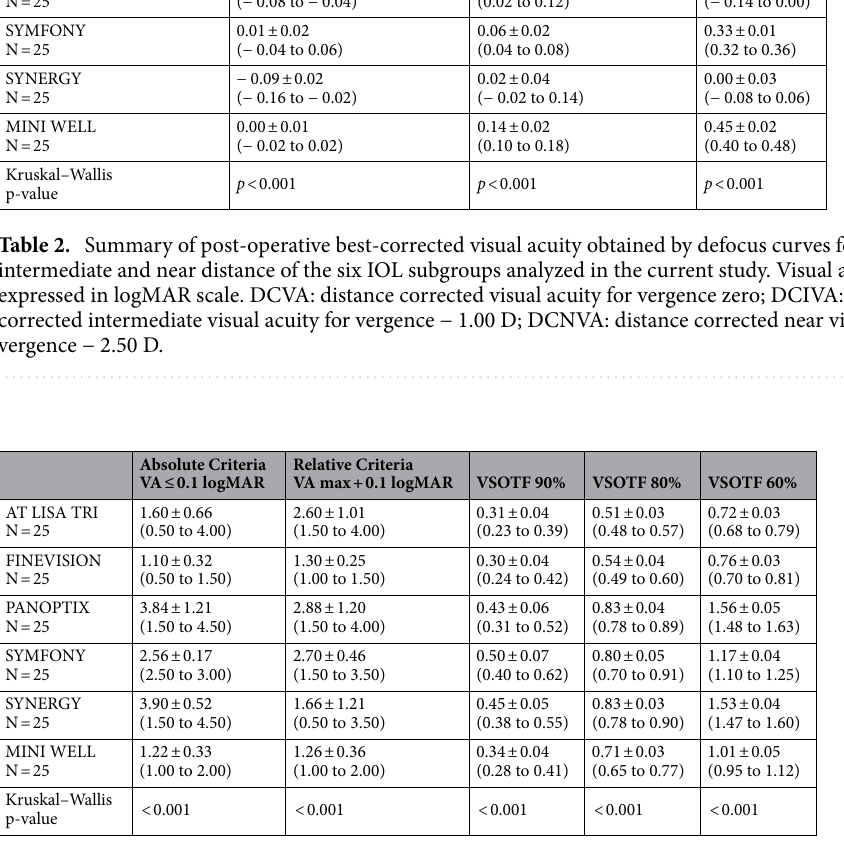
Table 3. Summary of the depth of field (DOF) measurements obtained under both subjective and objective conditions.